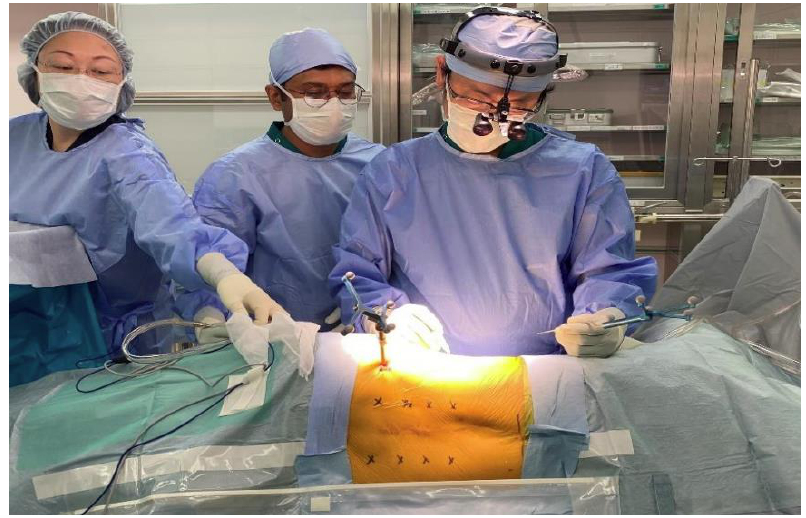
Figure 5. Position of the reference frame.